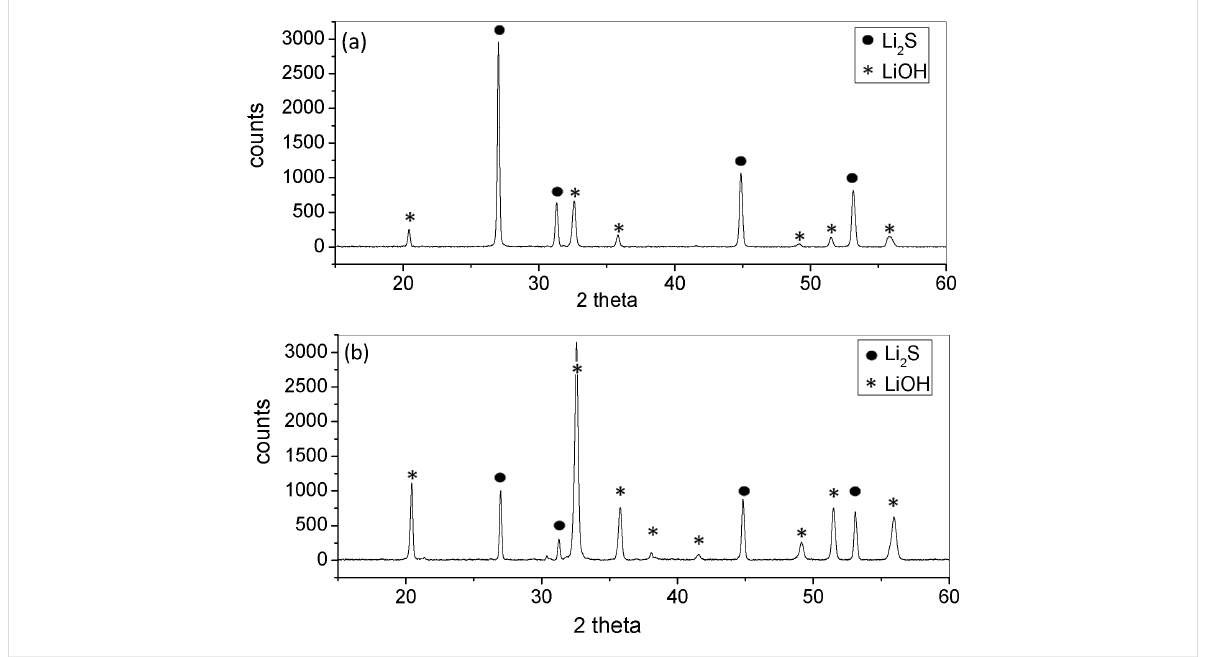
Figure 3: X-ray pattern of the Li 2 S sample before (a) and after (b) approximately 25 min in contact with air.